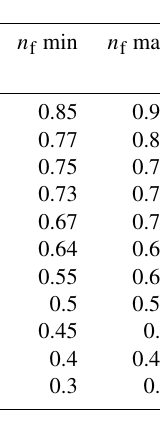
Table 1. Ranges of n f factors that were assigned to mean annual snowfall